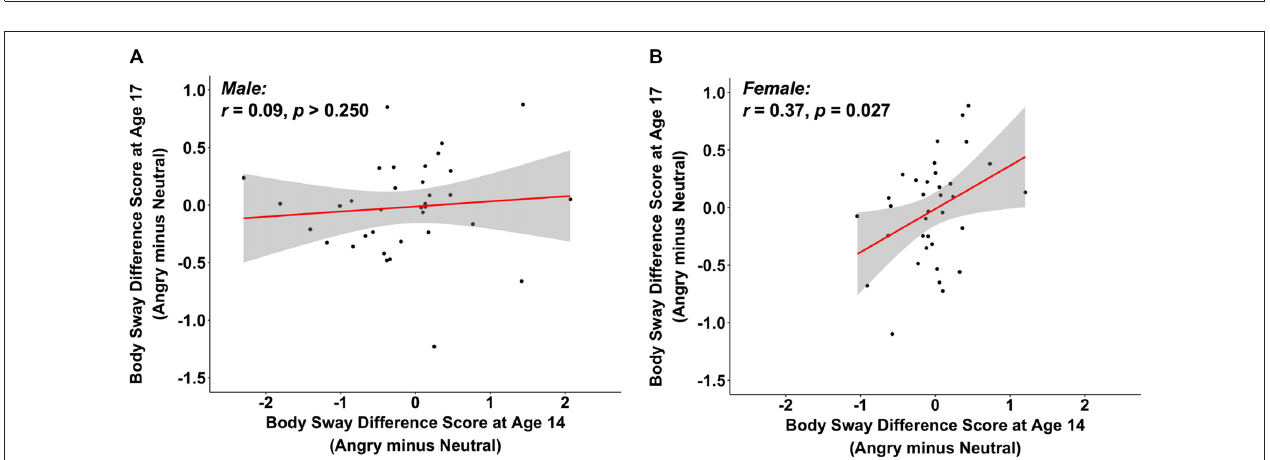
FIGURE 2 | The scatterplots (with best-fitting regression line) illustrate the correlations between changes in body sway variability (in mm) at ages 14 and 17 to angry vs. neutral faces, separately for male (A) and female participants (B) . Two multivariate outliers were excluded for the correlations in (A,B) .